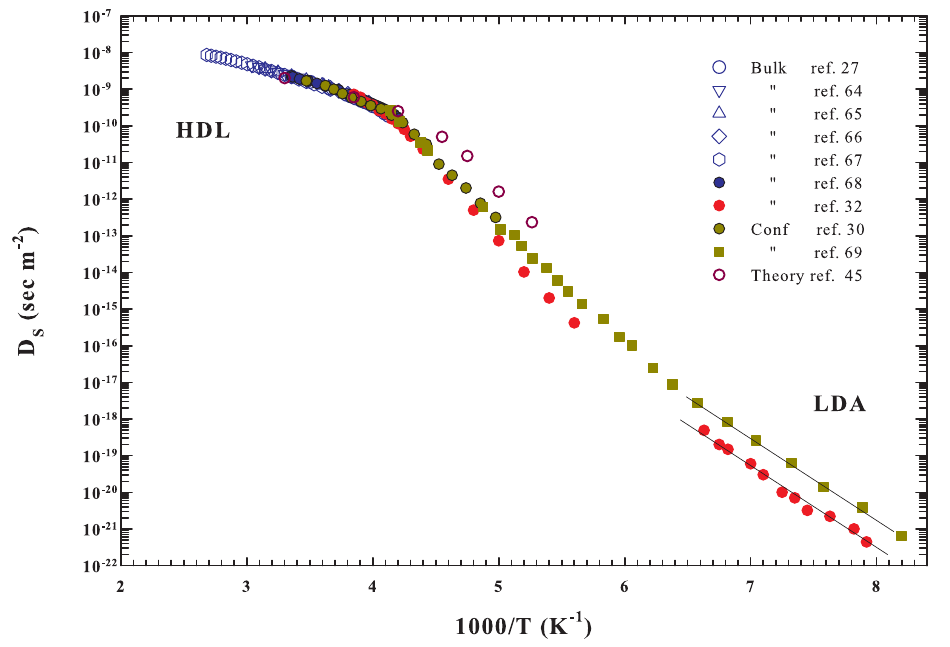
Figure 4. A collection of self-diffusion data is reported in an Arhhenius representation, D S vs. 1000/ T . Data come from bulk water (as blue symbols [27,64–68]), fused amorphous water (dark red [32]) together with MCM confined water (NMR [30] and dielectric relaxation data [69], dark yellow); data coming from the theoretical study, obtained from the evaluated C Conf by using the Adam–Gibbs (dark P pink open circles), are also reported [45]. These data cover a very large T - range from 373 to 120 K, with an overall variation of about 12 orders of magnitude, without the presence of any singularities. The two straight lines indicate the strong behavior at the lowest temperatures.